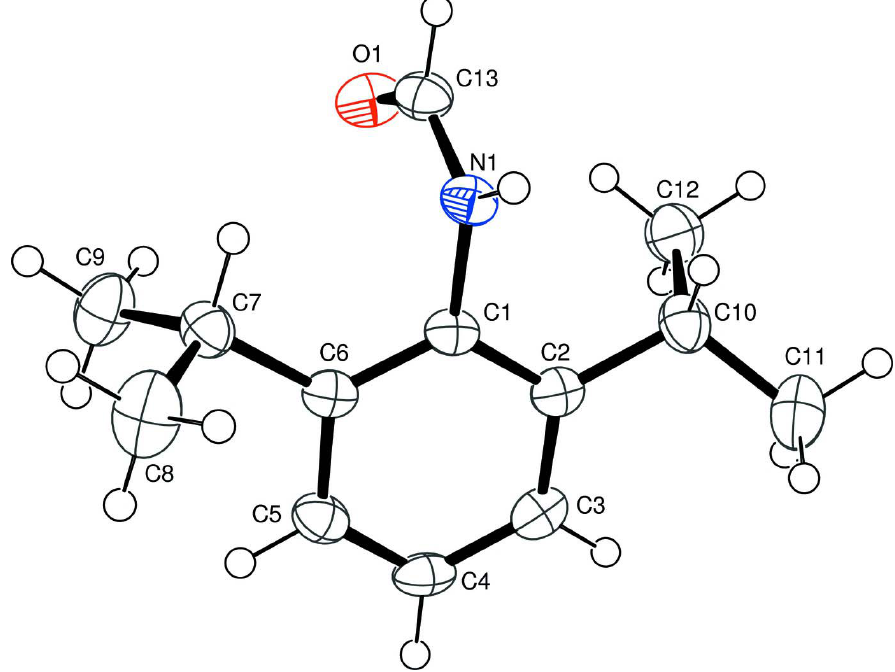
The molecular structure of (I), showing the atom-labeling scheme. Thermal ellipsoids are drawn at the 50% probability